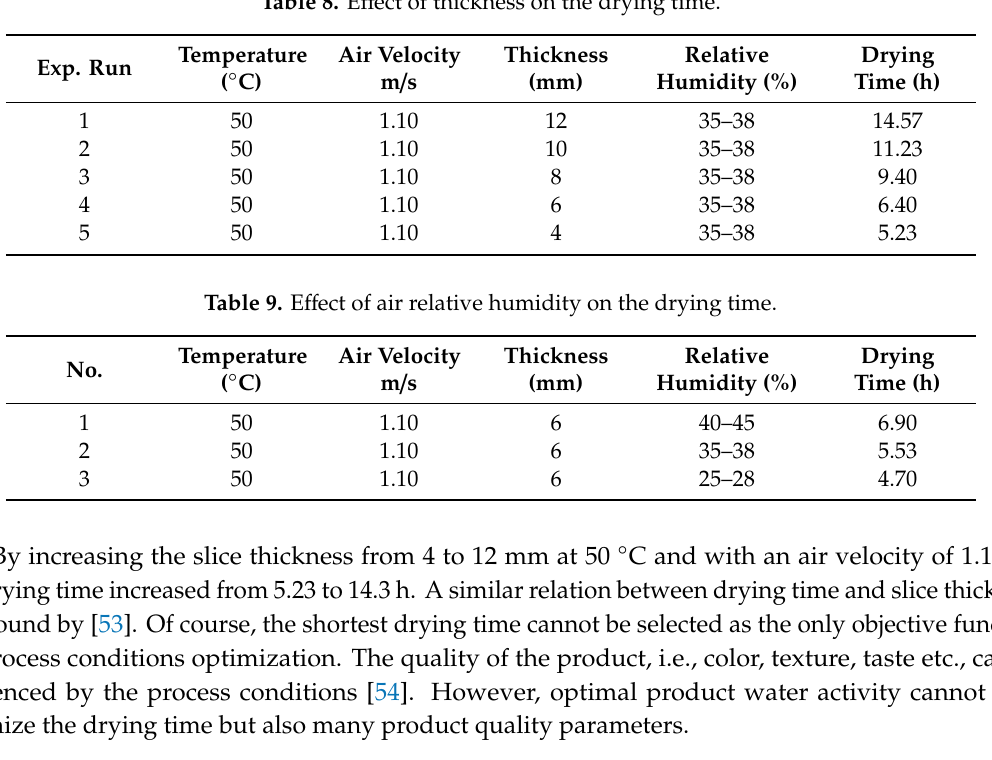
Table 8. E ff ect of thickness on the drying time.